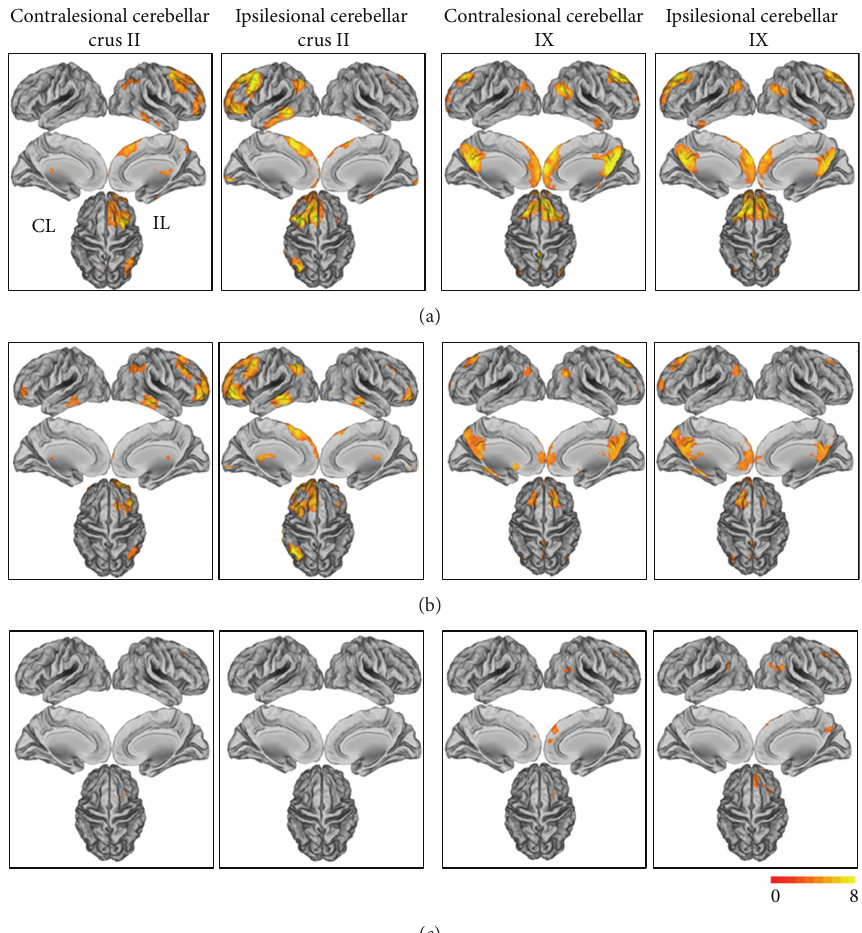
Figure 3: The rsFC patterns of the cerebellar subregions in healthy controls and stroke patients (total: 𝑛 = 25 ) and the rsFC differences between stroke patients and healthy controls ( 𝑃 < 0.05 corrected). (a) The rsFC patterns of the cerebellar subregions in healthy controls; (b) the rsFC patterns of the cerebellar subregions in stroke patients; (c) the differences in the rsFCs between stroke patients and healthy